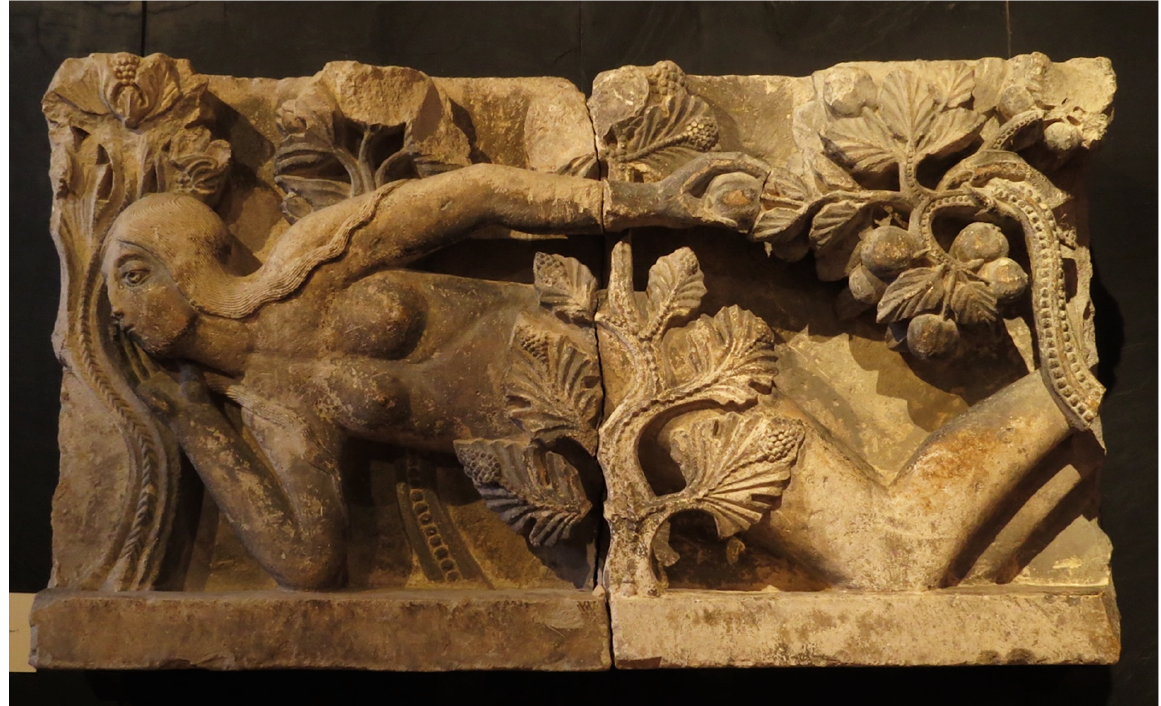
Figure 29. Gislbertus(?), Lintel Fragment of Eve , ca. 1120, Musée Rolin (originally from